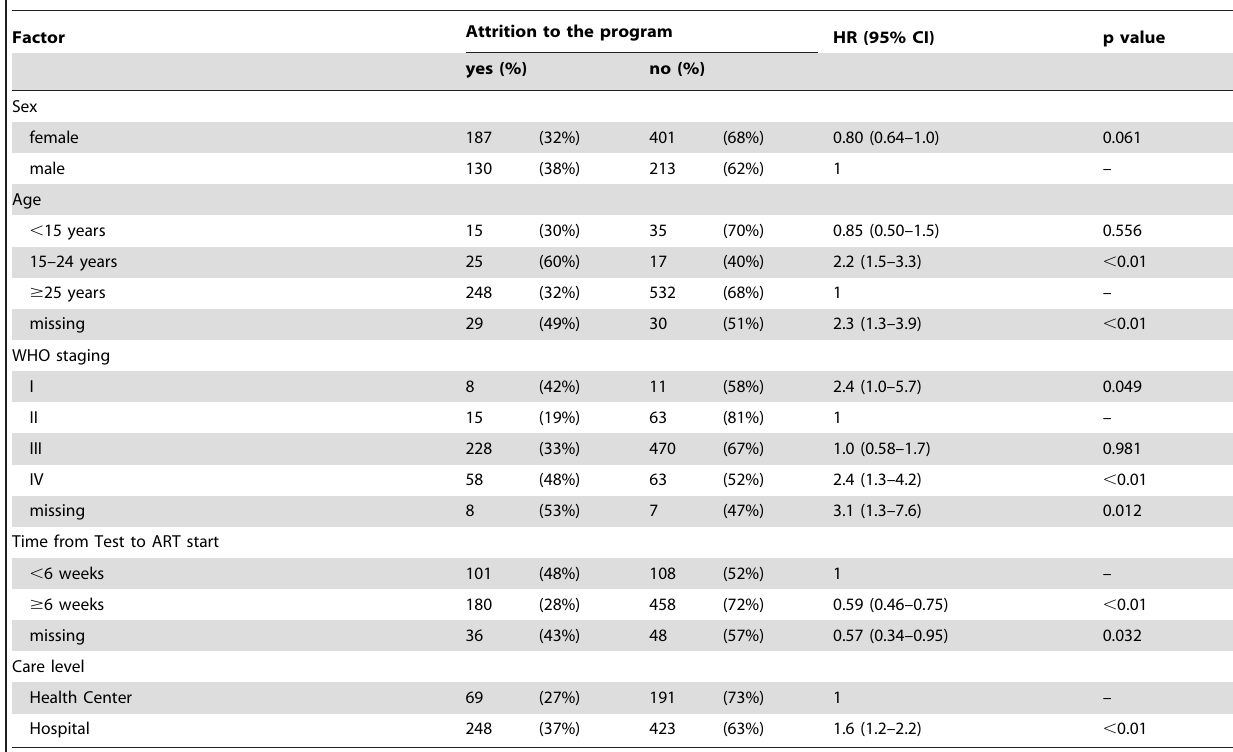
Table 3. Adjusted hazard ratios for attrition to the ART program